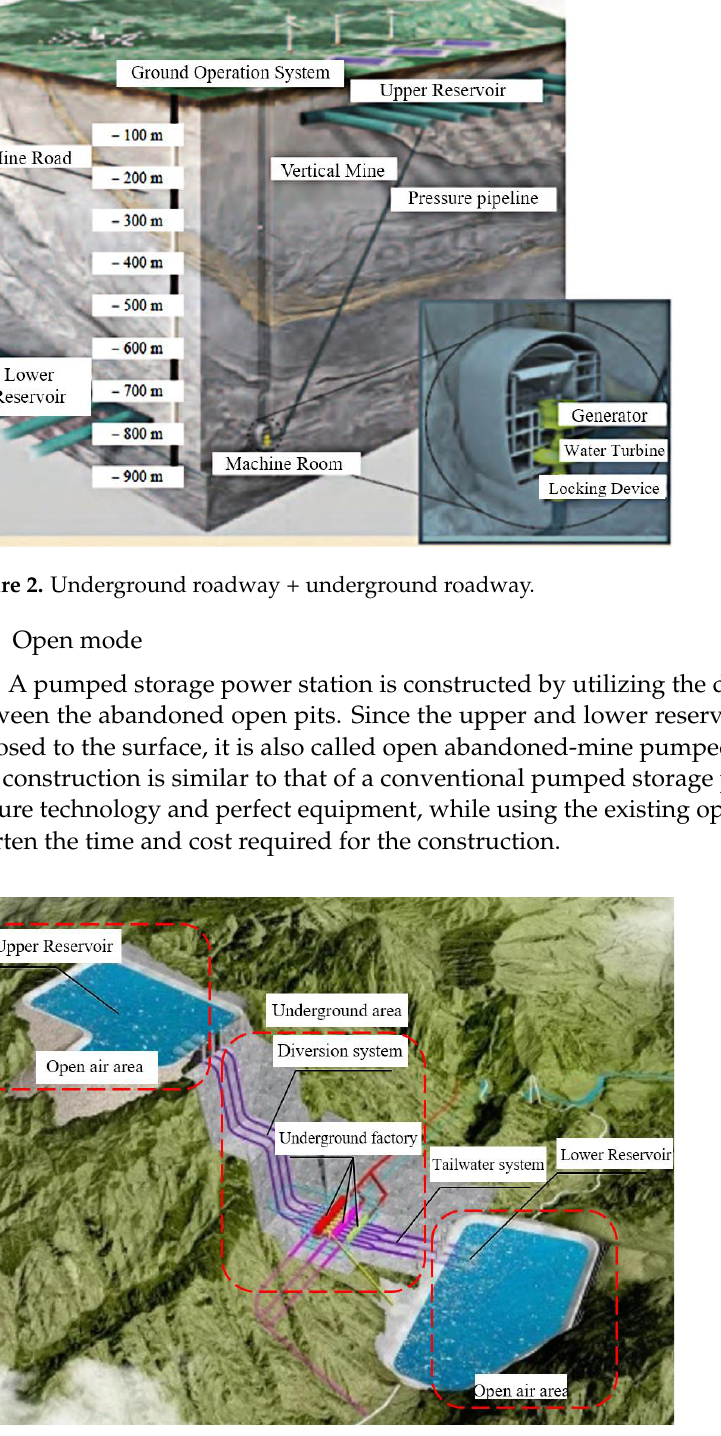
Figure 3. Open mode.